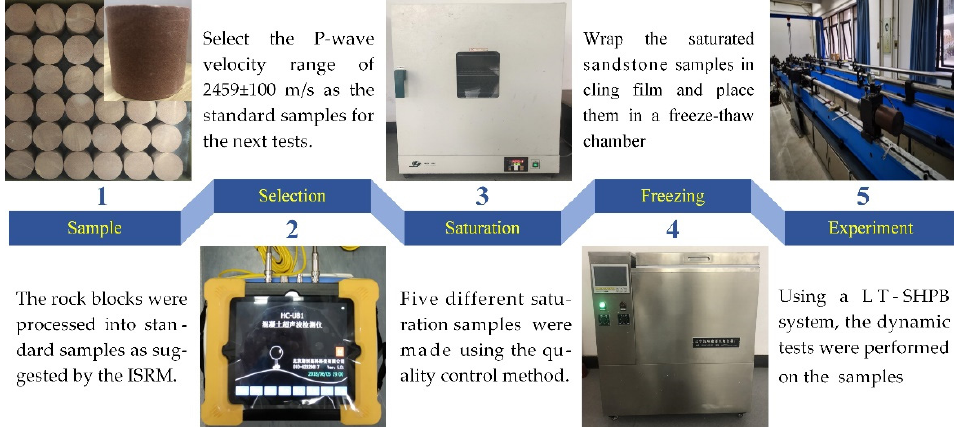
Figure 2. XRD result for the tested sandstone.